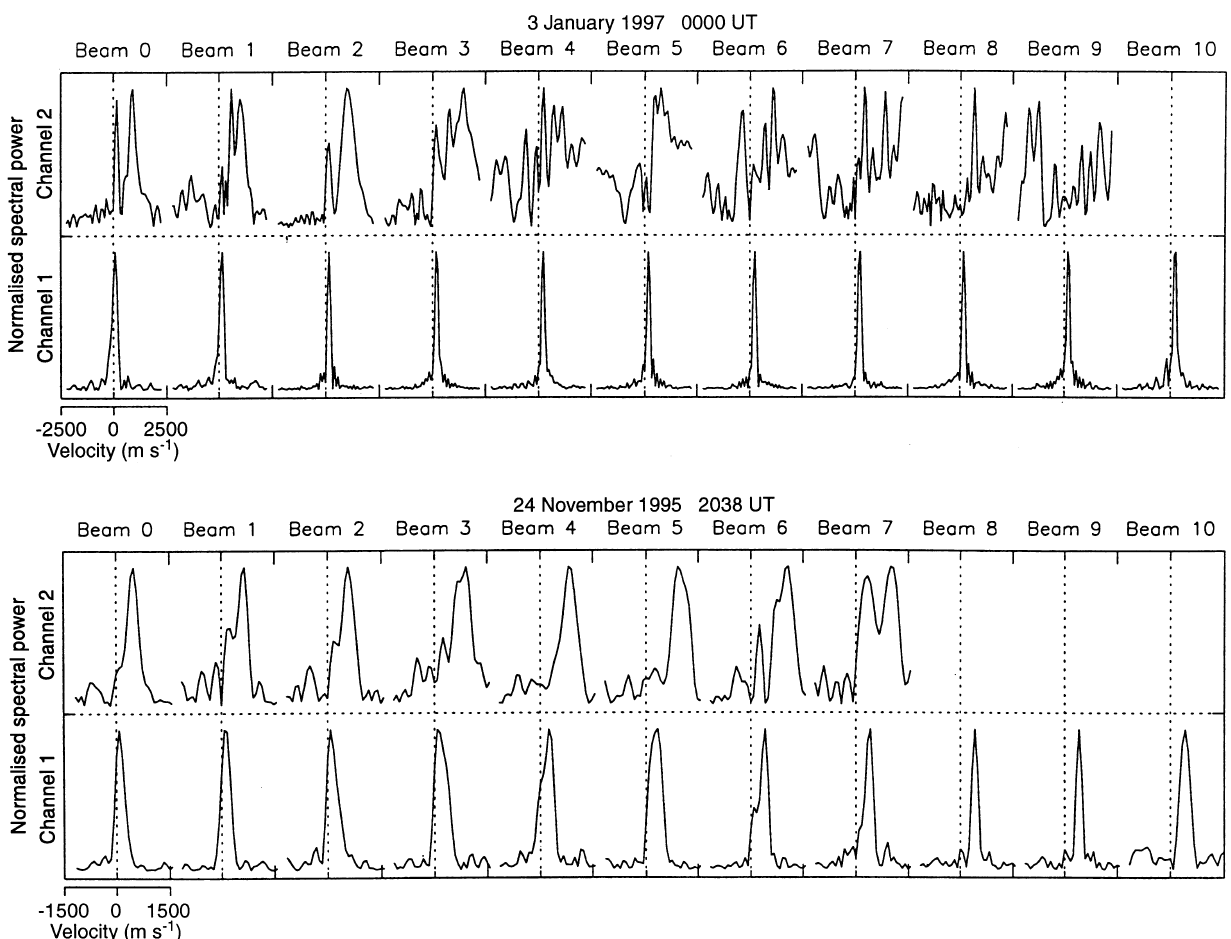
Fig. 6. A comparison of Doppler spectra observed along channels 1 and 2 at 0000 UT, 3 January 1997 and 2038 UT, 24 November 1995 (corresponding to a and d of Fig. 5). Note the di(cid:128)ering velocity scales for the